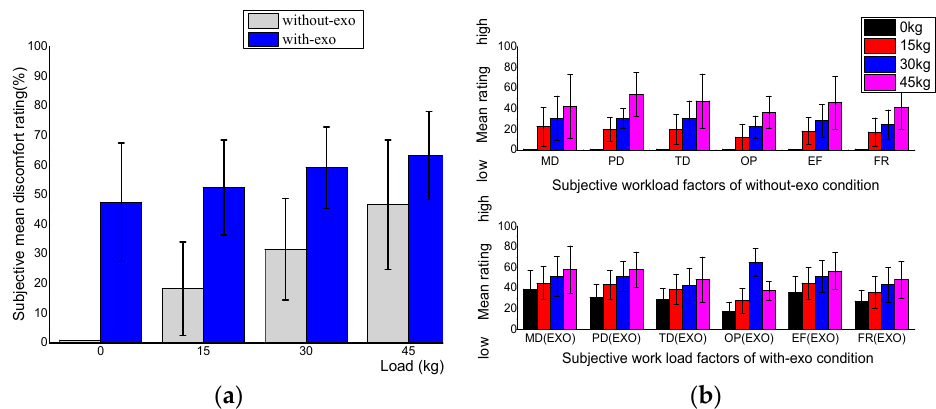
Figure 10. ( a ) The subjective discomfort performance. ( b ) The comparisons of mean rating value plots of the six workload factors.